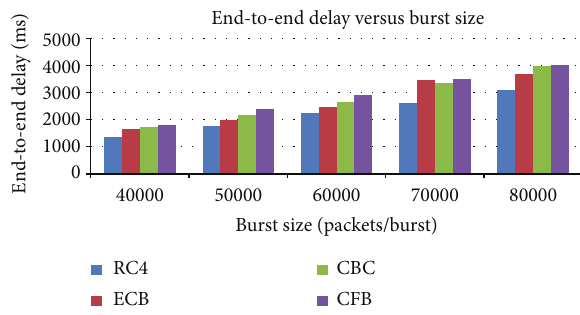
Figure 5: End-to-end delay of a burst using various encryption and decryption